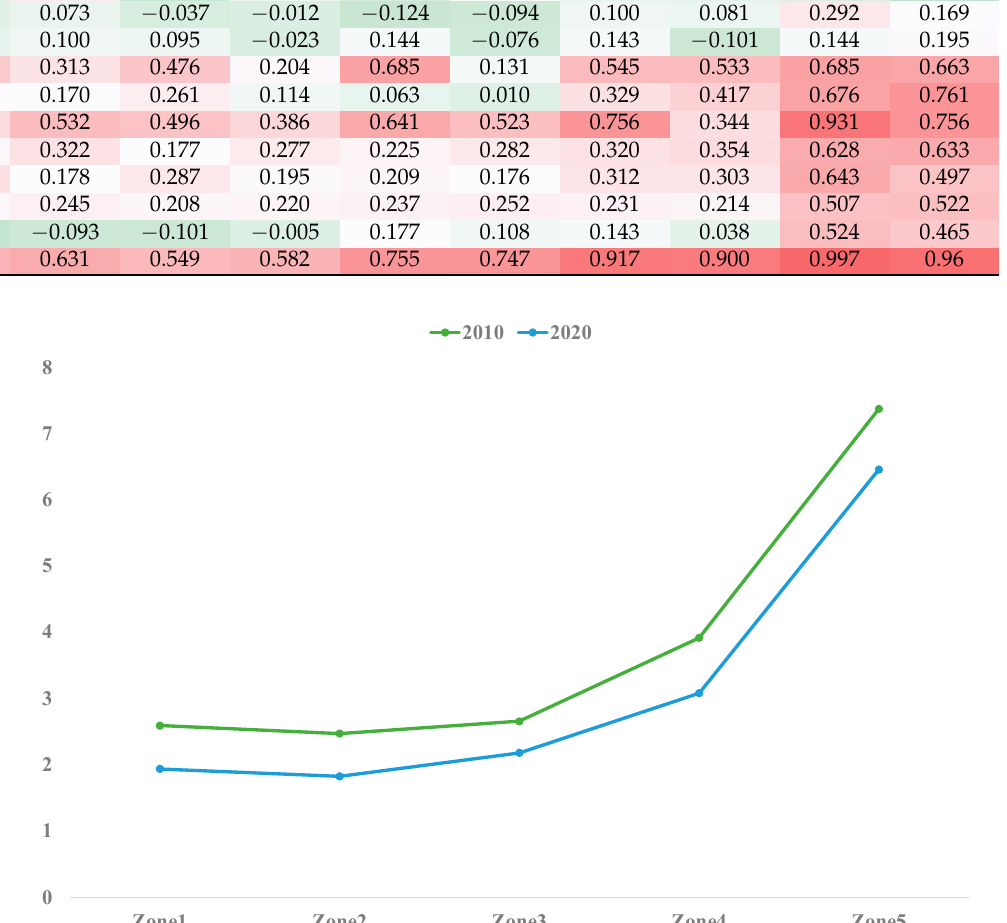
Figure 9. Evolutionary trend chart of the ES correlation coefficient sum of tea garden yield zoning in Fuzhou.